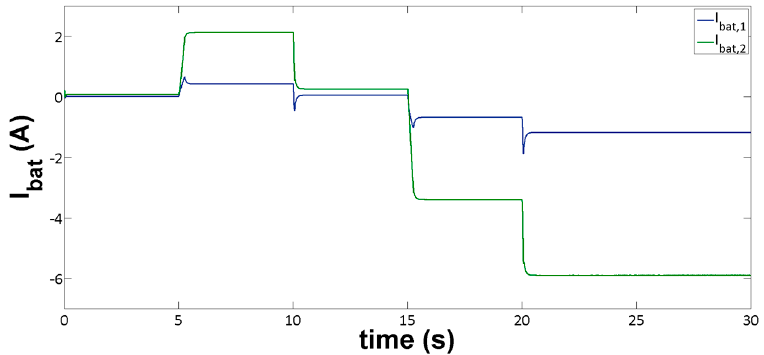
Figure 8. Current on each battery branch.